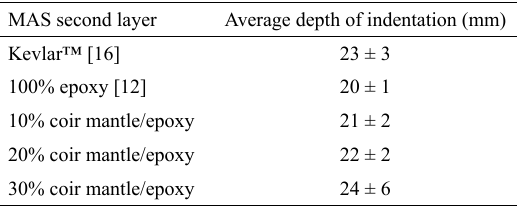
Table 2. Depth of indentation for MAS with different second layers ballistic tested against 7.62 mm bullet.